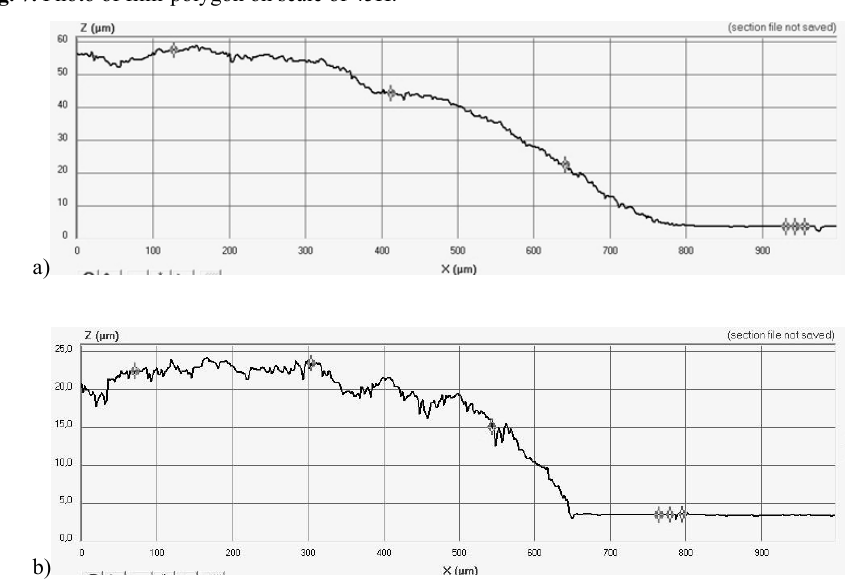
Fig. 8. Examples of profilograms of films after heat treatment: a) 180°С , b) 310°С